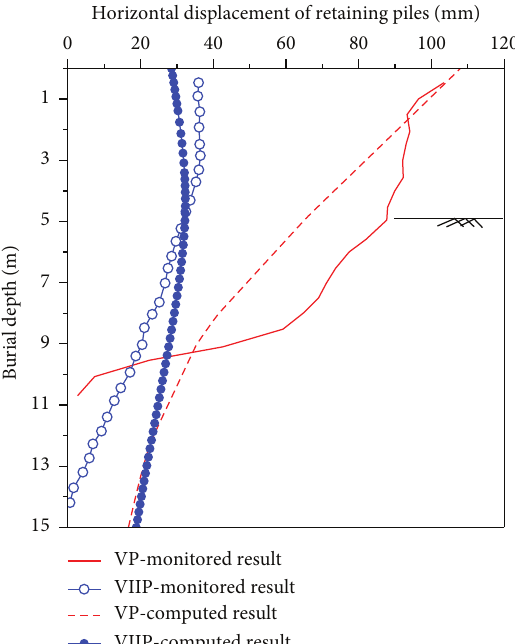
Figure 6: Monitored and computed results of VP and VIIP-20 ° in the field.